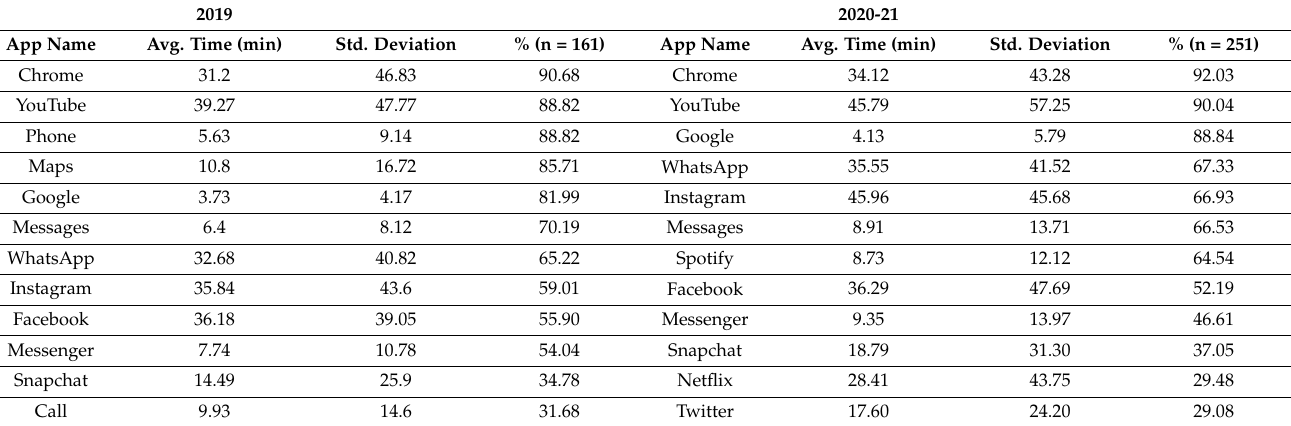
Table 3. Top 15 apps based on time spent in minutes in 2019 and